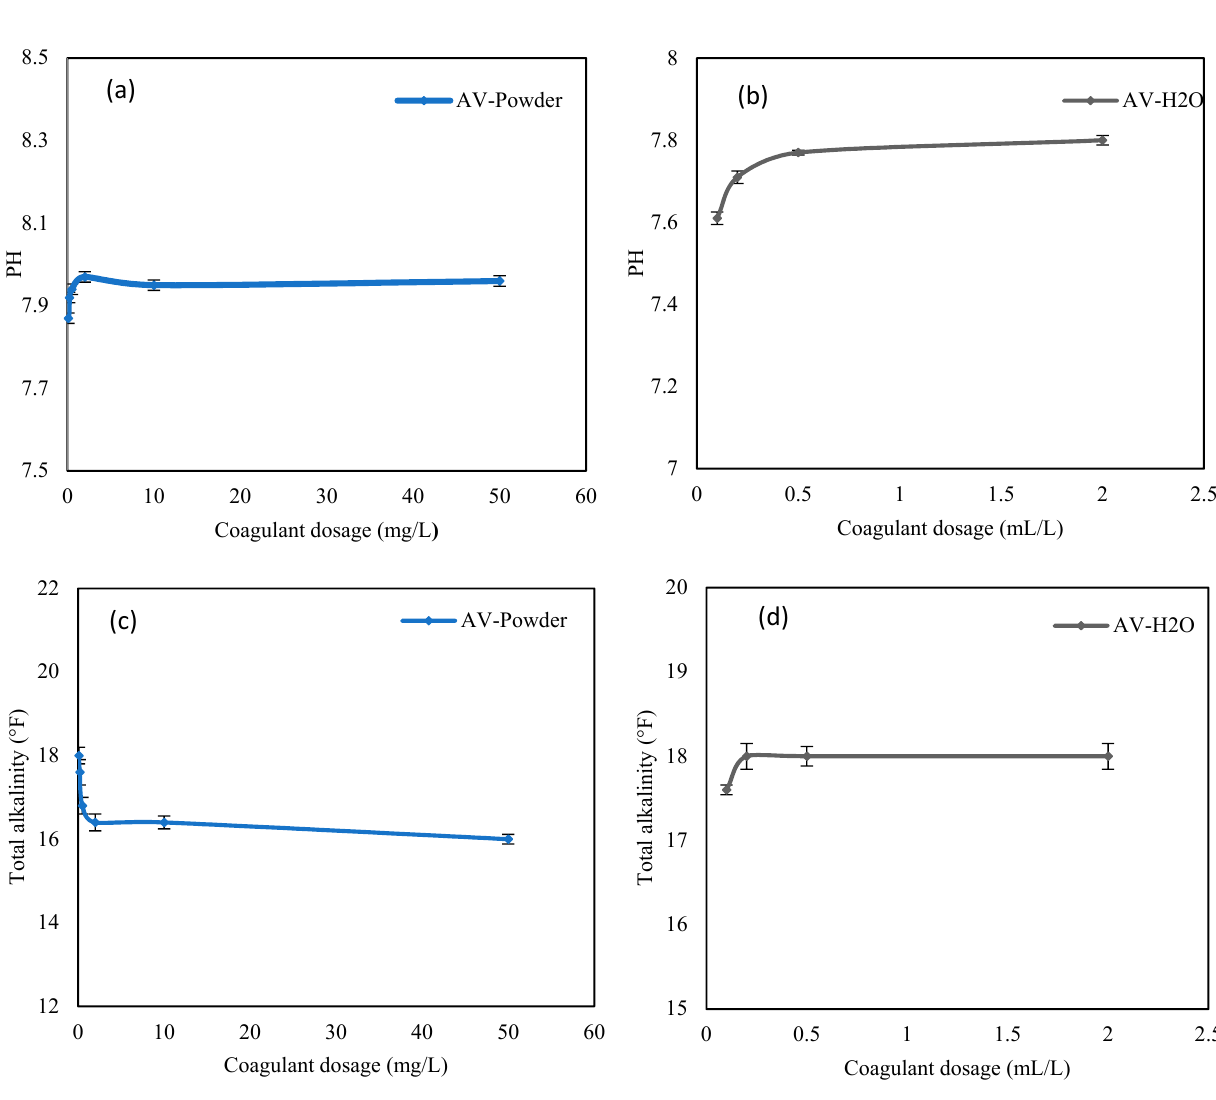
Figure 6. Effect of bio-coagulant dosage on: ( a , b ) pH; ( c , d ) total alkalinity by using AV-Powder and AV–H 2 O. (1°F = 10 mg CaCO 3 /L).